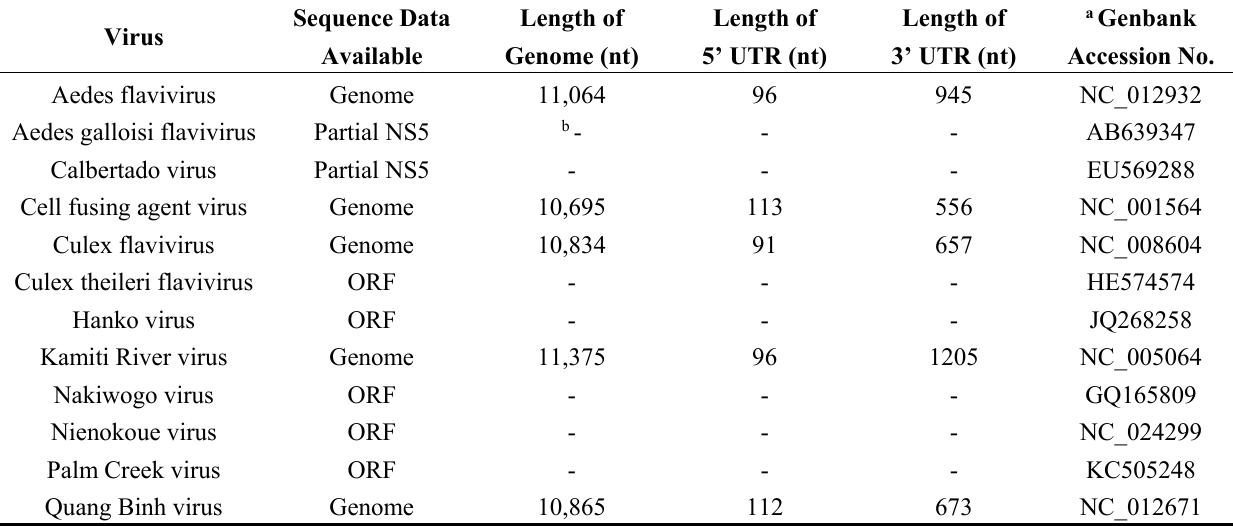
Table 2. Summary of sequence data available for classical insect-specific